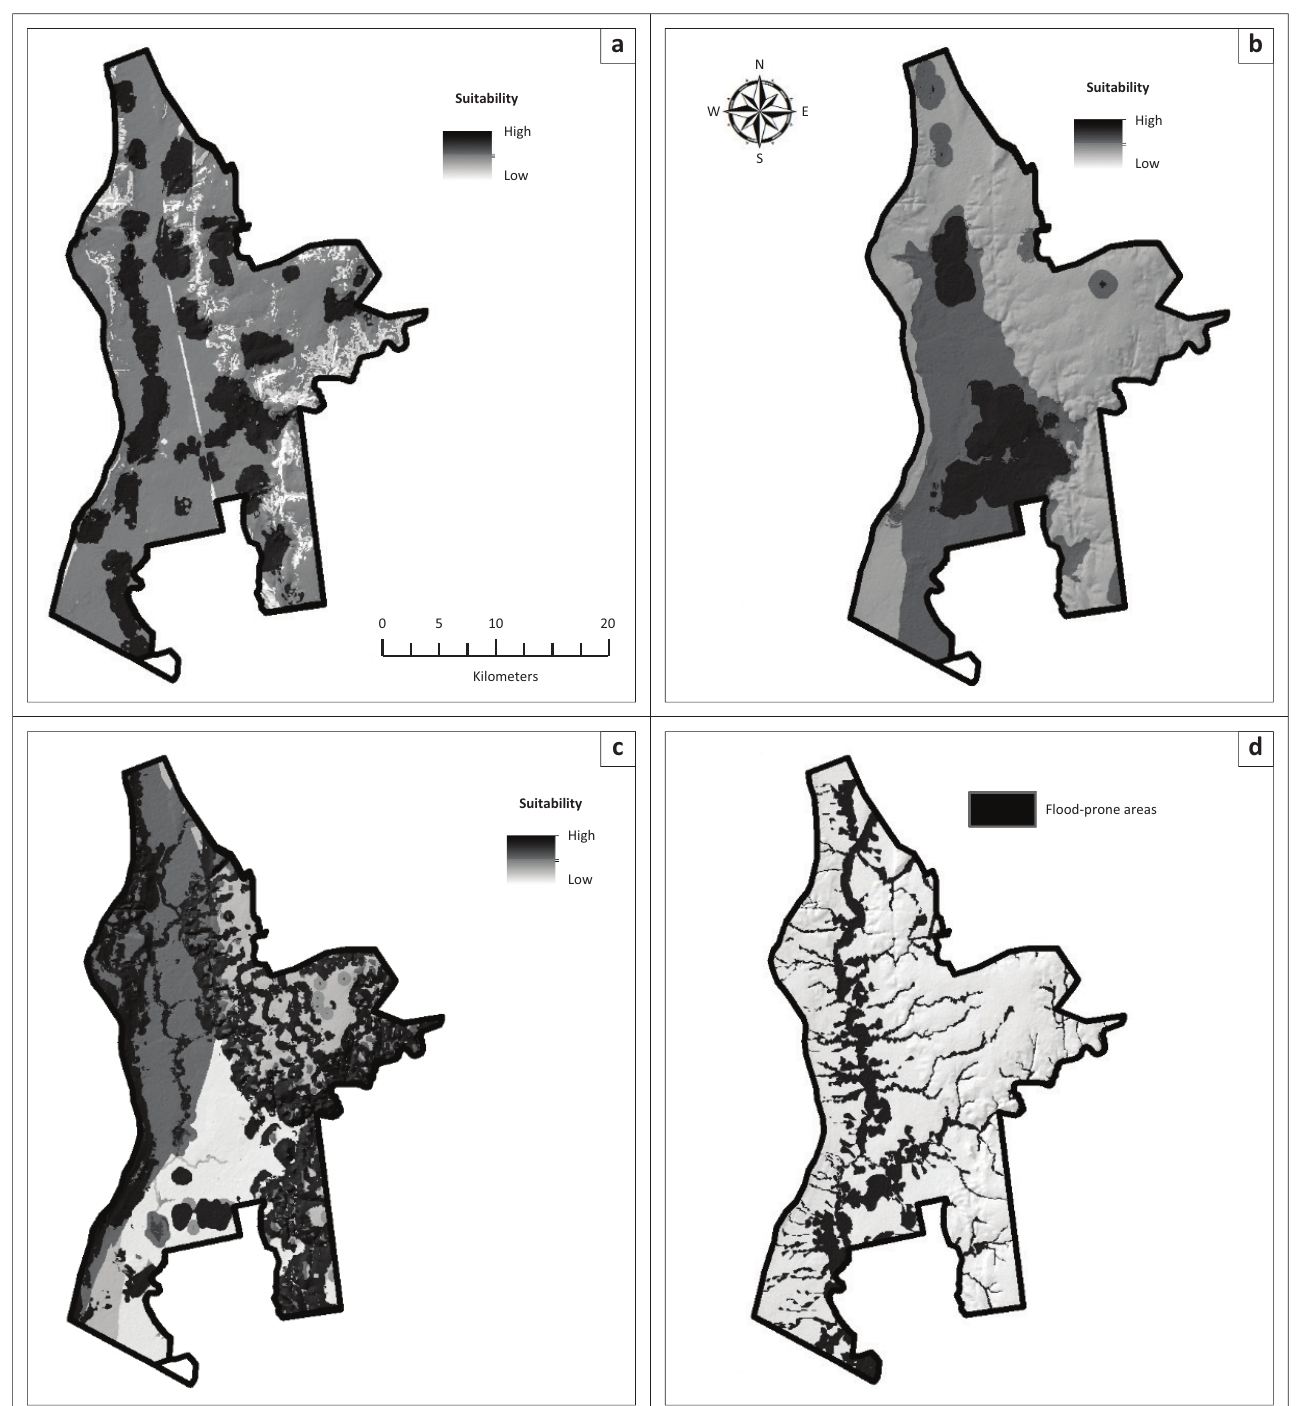
FIGURE 3: Suitability analysis results. (a) Urban, (b) agriculture, (c) conservation and (d) flood-prone